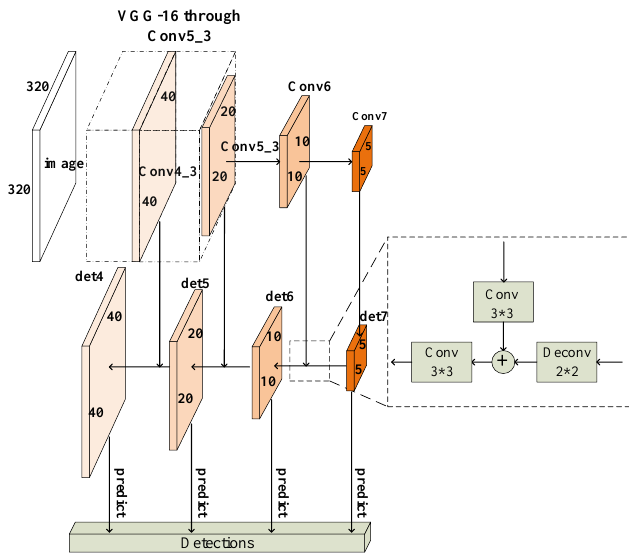
Figure 8. The feature extraction structure of the coarse-to-fine ship detection